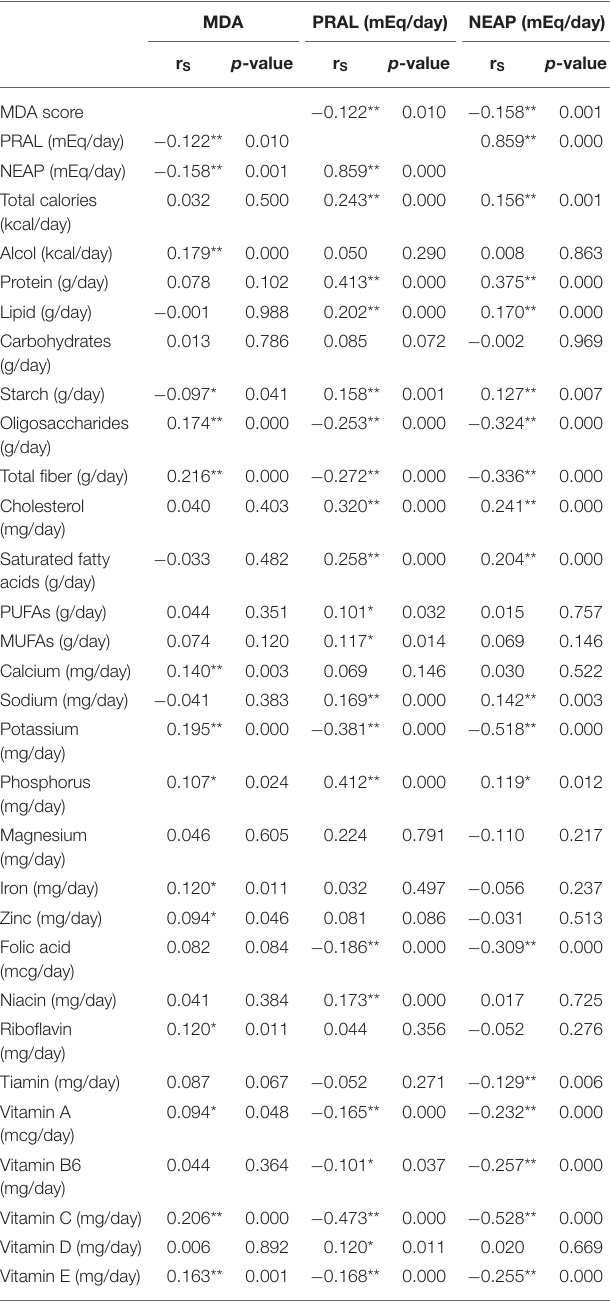
TABLE 2 | Correlation between MDA score, PRAL or NEAP, and dietary